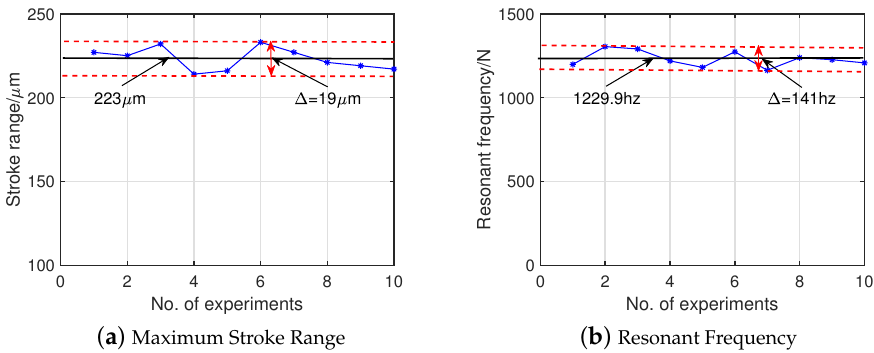
Figure 17. Ten sets of experimental data from test